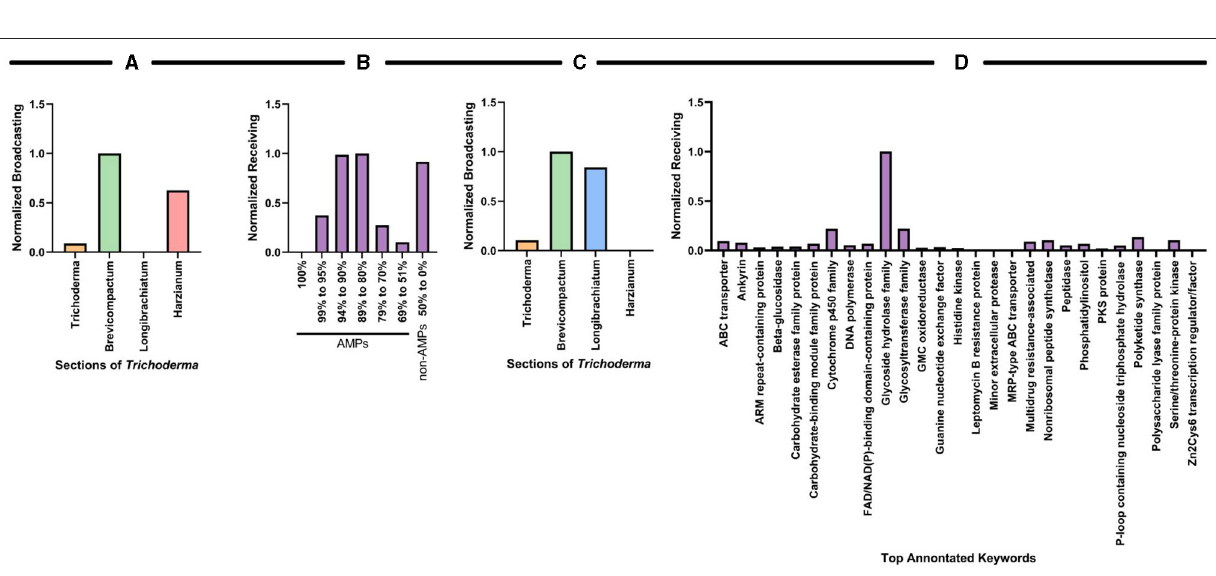
Extraction of Natural Products From